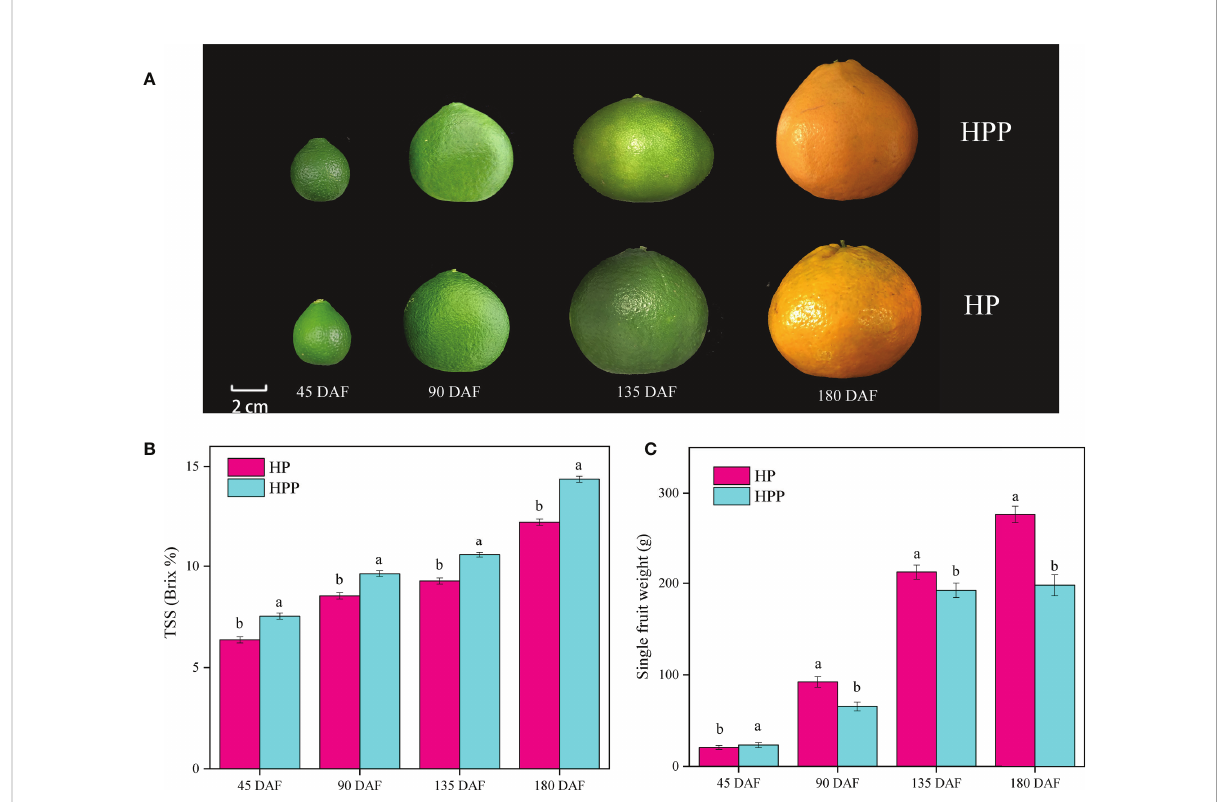
FIGURE 1 Changes in fruit phenotype, total soluble solid (TSS), and single-fruit weight between Harumi/Hongjv (HP) and Harumi/Ponkan/Hongjv (HPP). (A) Phenotypes, (B) TSS, and (C) single-fruit weights of HP and HPP fruits at 45, 90, 135, and 180 days after fl owering (DAF). Each value shown represents the mean ± SD of three biological